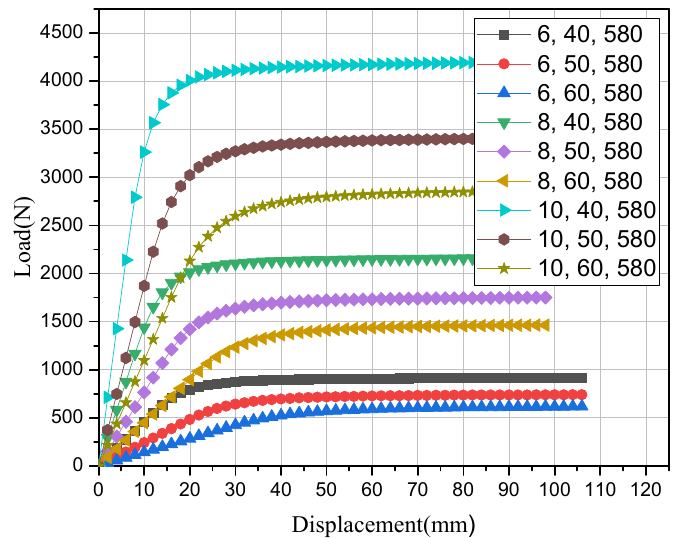
Figure 7. Load–displacement curves of SCDs ( n = 5).